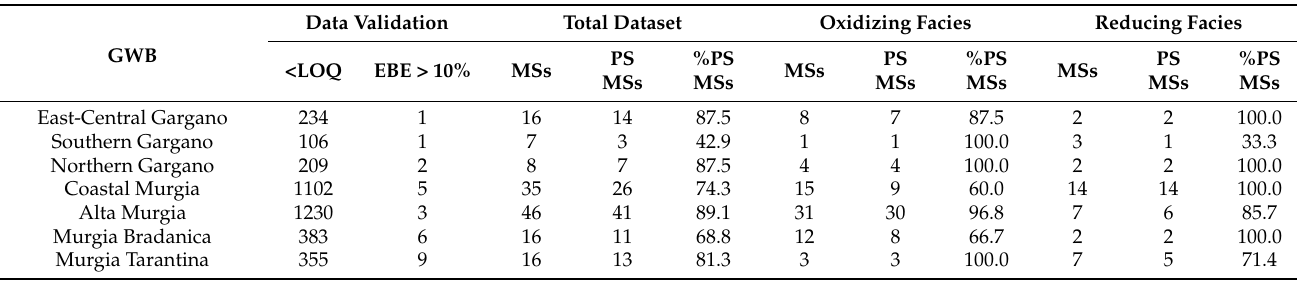
Table 5. Data validation and pre-selection of the monitoring stations. EBE = electrical balance error; MS = monitoring site; PS MSs = pre-selected monitoring sites.